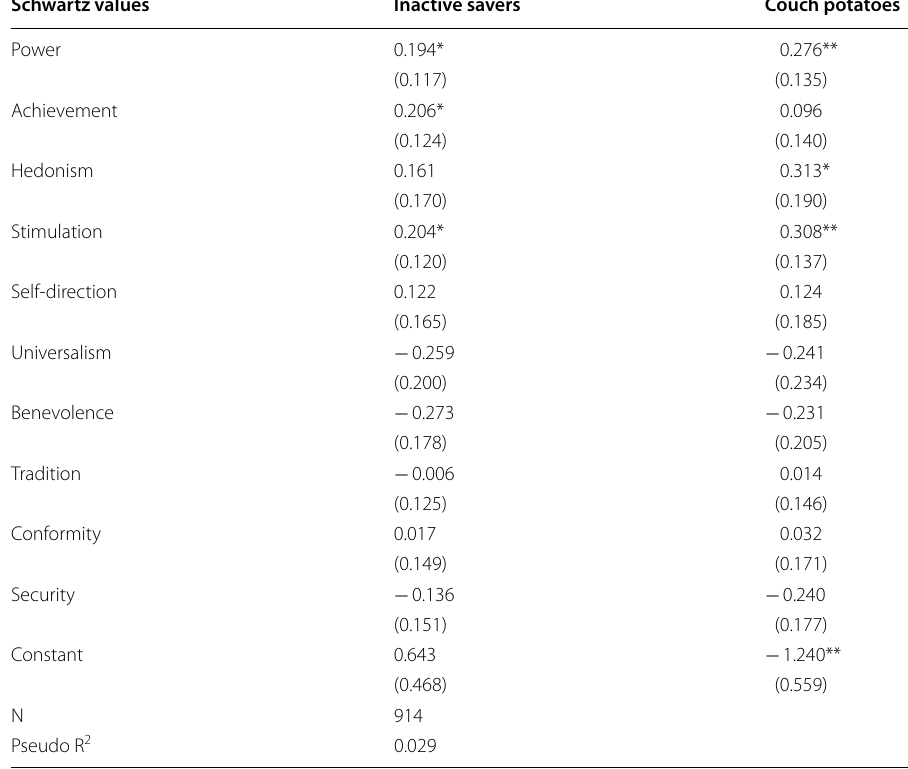
Table 7 Results of the multinomial logit